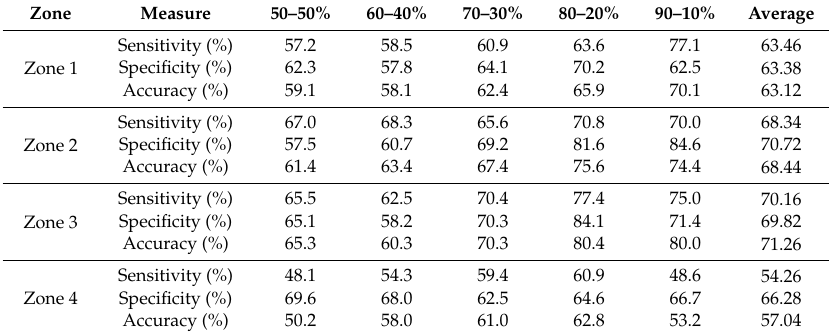
Table 7. Classification accuracy and values of sensitivity and specificity by the artificial neural network (ANN) classifier for size of wildfire with 50–50%, 60–40%, 70–30%, 80–20%, and 90–10% partitions in training-test, respectively.